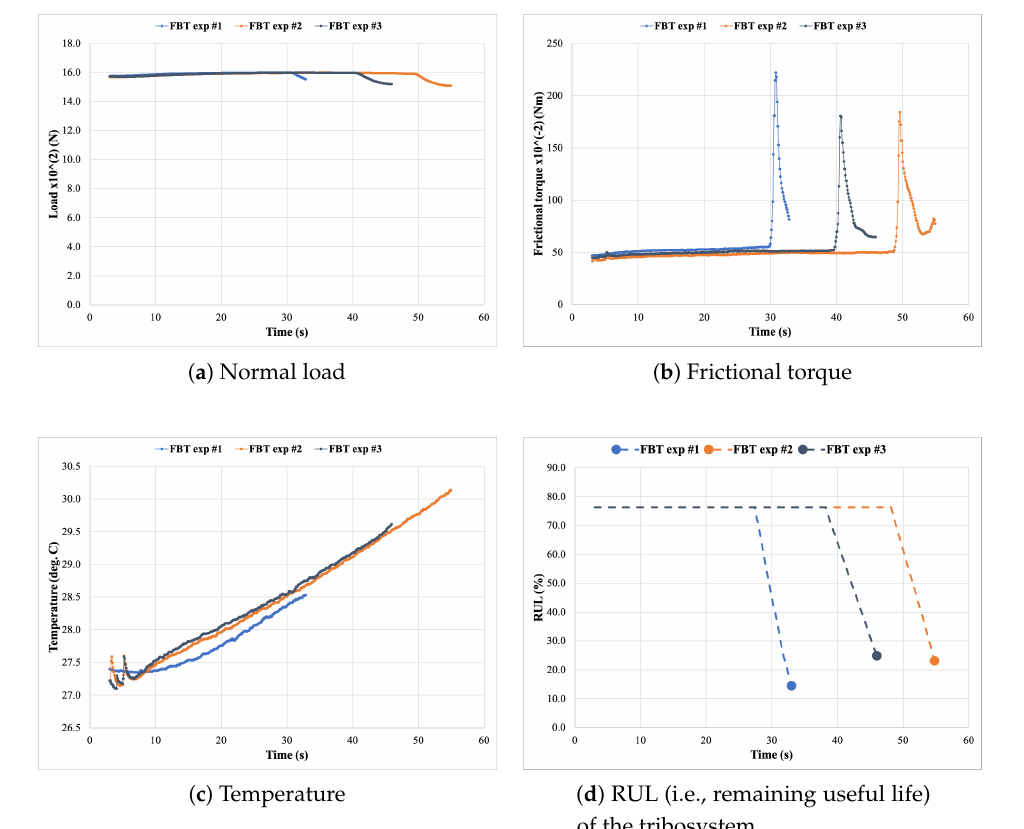
Figure 8. Processed data from the three FBT experiments that would serve as the data for the deep learning